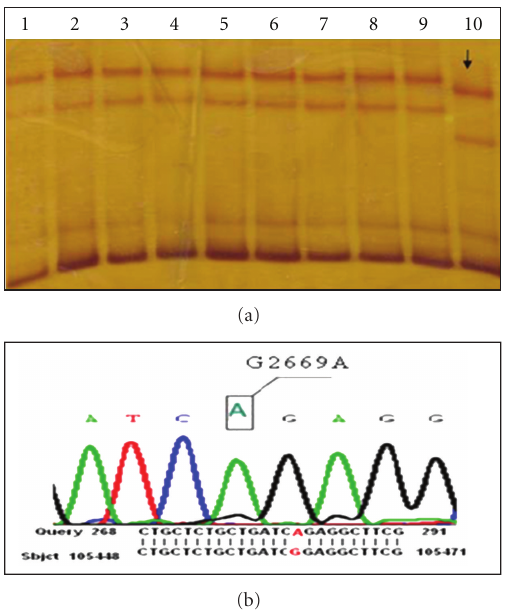
Figure 1: (a) SSCP analysis of exon 15 fragments of thyroid perox- idase (TPO) gene in nine patients with thyroid dyshormonogenesis of Isfahan, Iran. Line 1:normal control. Line 2–8: patients that did not have aberrant shift and mutation in exon 15. Line 9: the patient with homozygous G2669A mutation in exon 15. (b) Sequencing analysis result of patient with homozygous G2669A mutation in exon